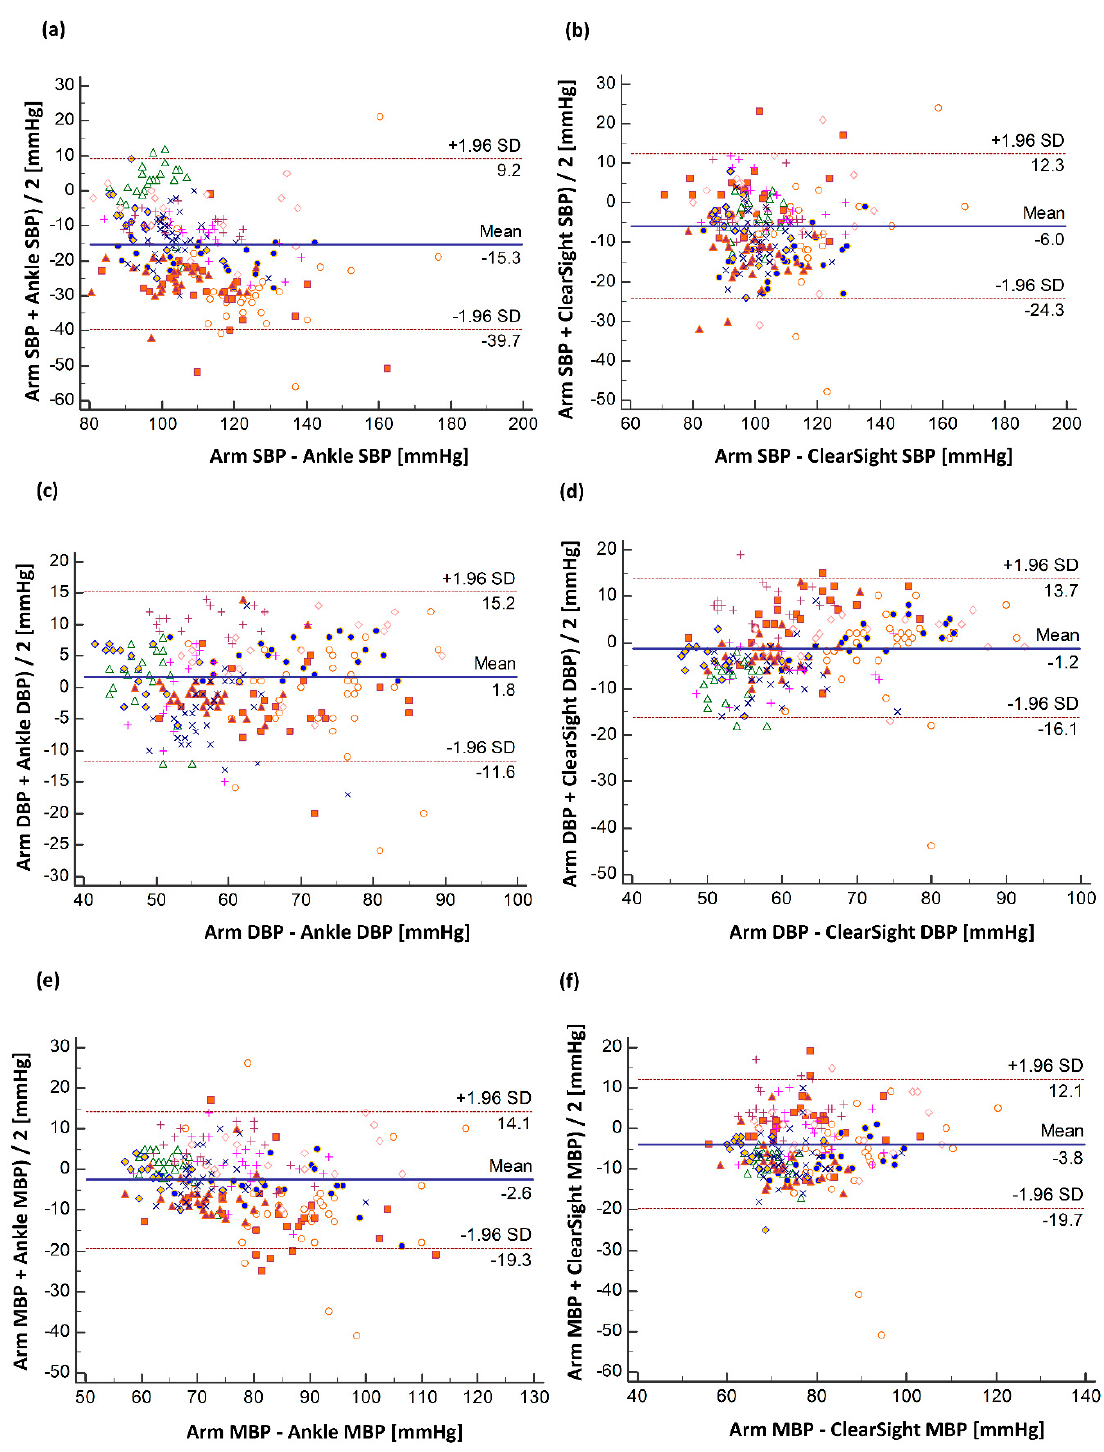
Figure 3. Bland–Altman plot for BP measurements. ( a ) Bland–Altman analysis between systolic blood pressure (SBP) of arm and ankle. ( b ) Bland–Altman analysis between SBP of arm and ClearSight. ( c ) Bland–Altman analysis between diastolic blood pressure (DBP) of arm and ankle. ( d ) Bland–Altman analysis between DBP of arm and ClearSight. ( e ) Bland–Altman analysis between mean blood pressure (MBP) of arm and ankle. ( f ) Bland–Altman analysis between MBP of arm and ClearSight. Each color of dot represents the measurements from each